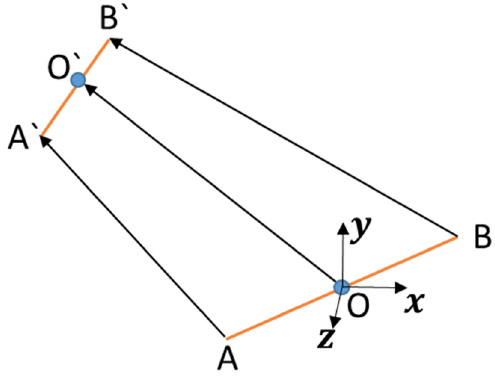
Figure 8. Robot body movement diagram.